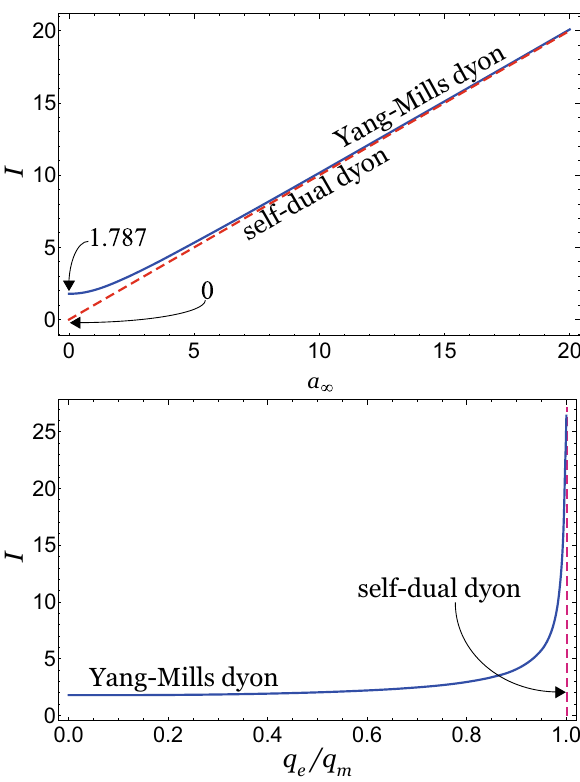
Fig. 11 Theenergyintegral(139)oftheYang–Millsdyonasafunction of a ∞ (top panel) and q e / q m (bottom panel), which are denoted by the solid lines. The broken lines are the energy integral (121) of the SD dyon as a constituent of the KvBLL